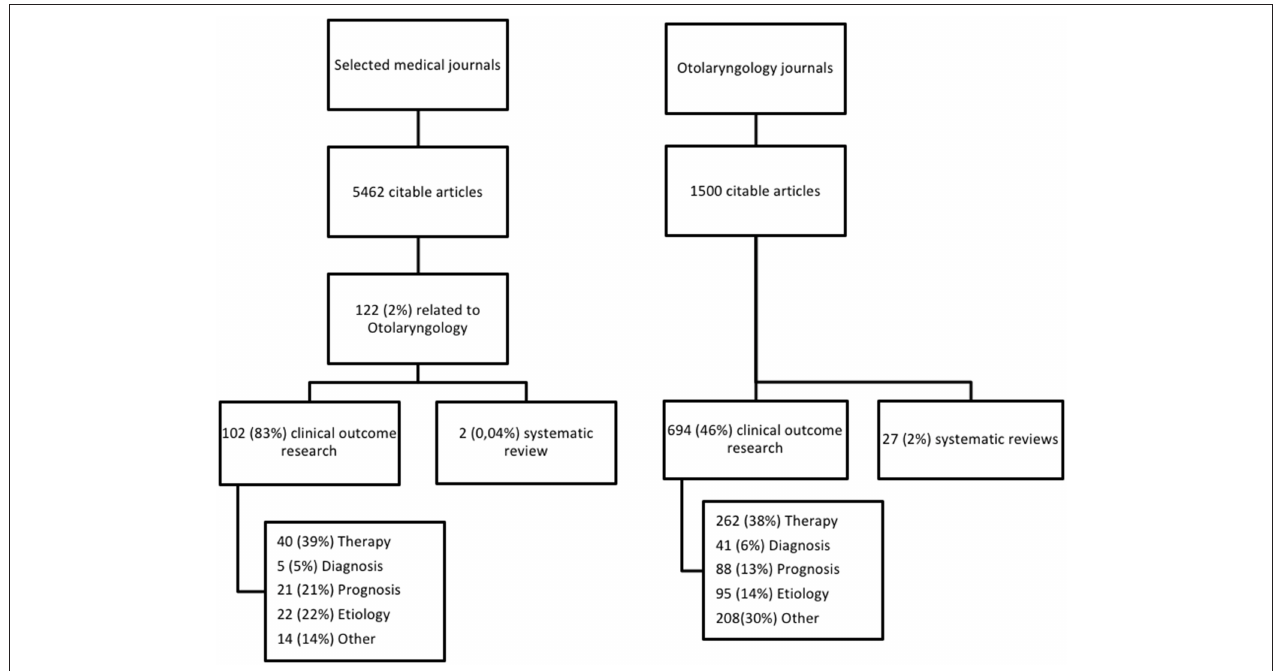
FIGURE 2 | Selection of